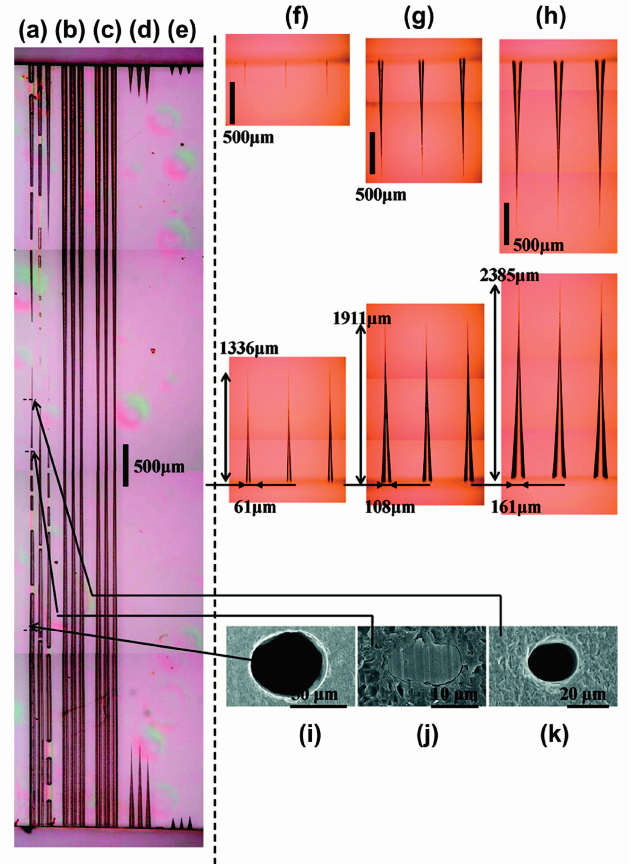
Figure 8. Reflectance optical micrographs of etching profiles in silica glass substrate (9.2 mm × 10 mm × 0.5 mm) using 10 M (35.8%) aqueous KOH (20 mL) and 2.0% aqueous HF (20 mL). The optical micrograph on the left shows channels fabricated after soaking for 60 h in KOH at 80 °C, following irradiation using femtosecond pulse trains (interval: 0.1 μ m) through a 40× objective lens (NA: 0.65), 10 μ m below the surface at different laser powers of ( a ) 500; ( b ) 400; ( c ) 300; ( d ) 200; and ( e ) 100 nJ/pulse. The optical micrographs on the top-right show the time evolution of channel formation in aqueous HF at ambient temperature (both ends of the channels shown). The specimen was irradiated with a laser power of 360 nJ/pulse through a 40× objective lens (NA: 0.65) and submerged in the solution for ( f ) 24; ( g ) 48; and ( h ) 72 h. The FE-SEM images on the bottom right show cross sections of the leftmost channel in (a) at the positions indicated. In ( i ) and ( k ); the channels are open, whereas in ( j ); the channel is still filled with precipitates [85] (Reprinted with permission from ACS. © 2009 by the American Chemical